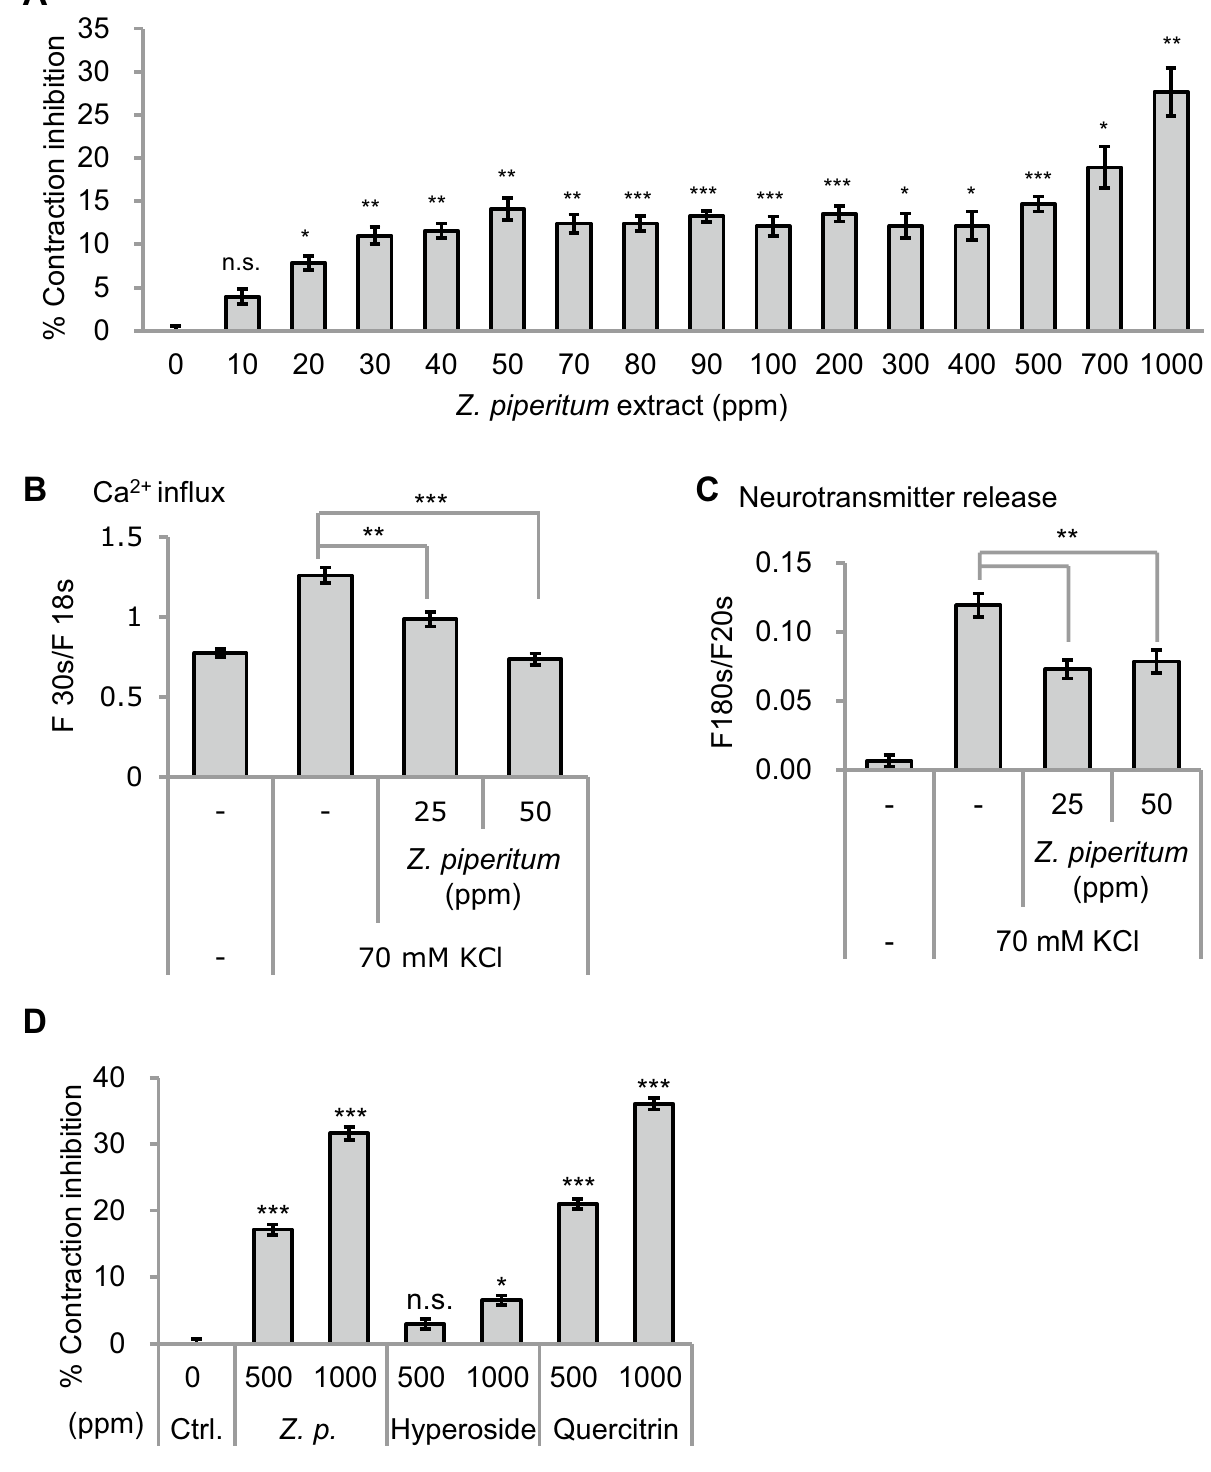
Figure 2. Identification of Z. piperitum extract as a BoNT-like ingredient. ( A ) Zanthoxylum piperitum ( Z. piperitum ) extract treatment inhibited muscle contraction rates in a dose-dependent manner. ( B and C ) Mechanisms of how Z. piperitum extract inhibits muscle contraction. Z. piperitum extract treatment reduced Ca 2+ ion influx into the neuronal cells (n = 5) ( B ), resulting in a decrease in neurotransmitter release (n = 7) ( C ). ( D ) Effects of hyperoside or quercitrin treatment on muscle contraction rates. Hyperoside treatment had little or no effect on muscle contraction, however, quercitrin treatment inhibited muscle contraction. All the muscle- contraction assays were repeated at least twice. Z. p. indicates Z. piperitum extract. Error bars represent standard error of mean (S.E.M., * p < 0.05, ** p < 0.01, *** p < 0.001, two ‐ tailed Student’s t ‐